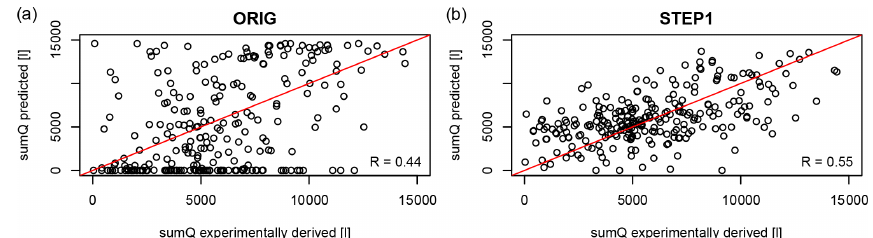
Figure 4. Surface runoff simulated with the derived skinfactor versus the ORIG skinfactor (a) and STEP1 skinfactor (b) .